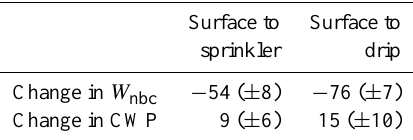
Table 4. Mean basin-level changes in non-beneficial consumption ( W nbc ) and crop water productivity (CWP) through system transi- tions from surface to sprinkler and drip; area-weighted means over all simulated basins in %.